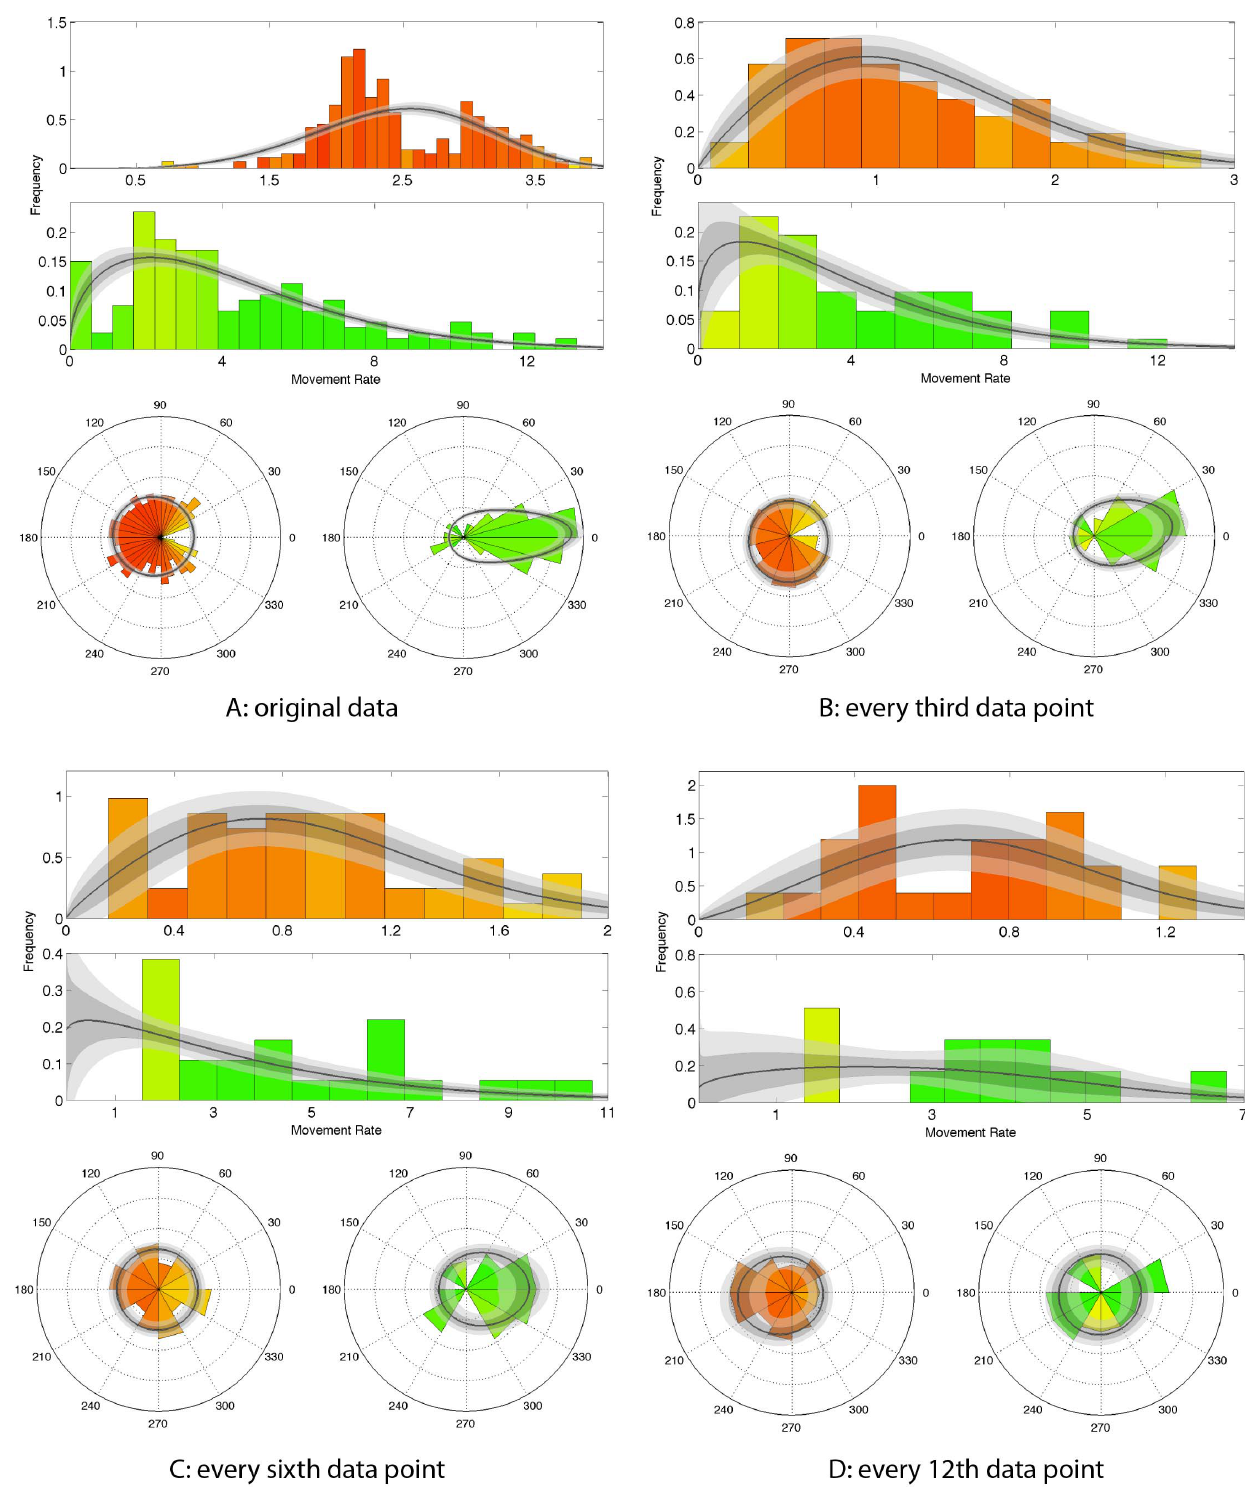
Figure 5. Movement-rate and turning-angle distributions for MCMC output from synthetic data. Each sub-figure shows, for each state in the two-state model, movement-rate (top) and turning-angle (bottom) distributions, at subsampling frequencies of (a) 1, (b) 3, (c) 6 and (d) 12 units, where the original data are ‘observed’ every unit. Solid lines are posterior Weibull and wrapped Cauchy distributions, with + one (two) posterior standard deviations shown in dark (light) grey. Histograms are observed frequencies, with division of data into states using output from MCMC computations. Histogram bars are coloured according to the mean probability of observations in that bar being in State 1 or 2, as given in the colour bar in Fig. 1, that is, red bars are more likely to be in State 1 and green bars more likely to be in State 2. Yellow bars are close to being undetermined - that is, they have an approximately equal probability of being in either state.